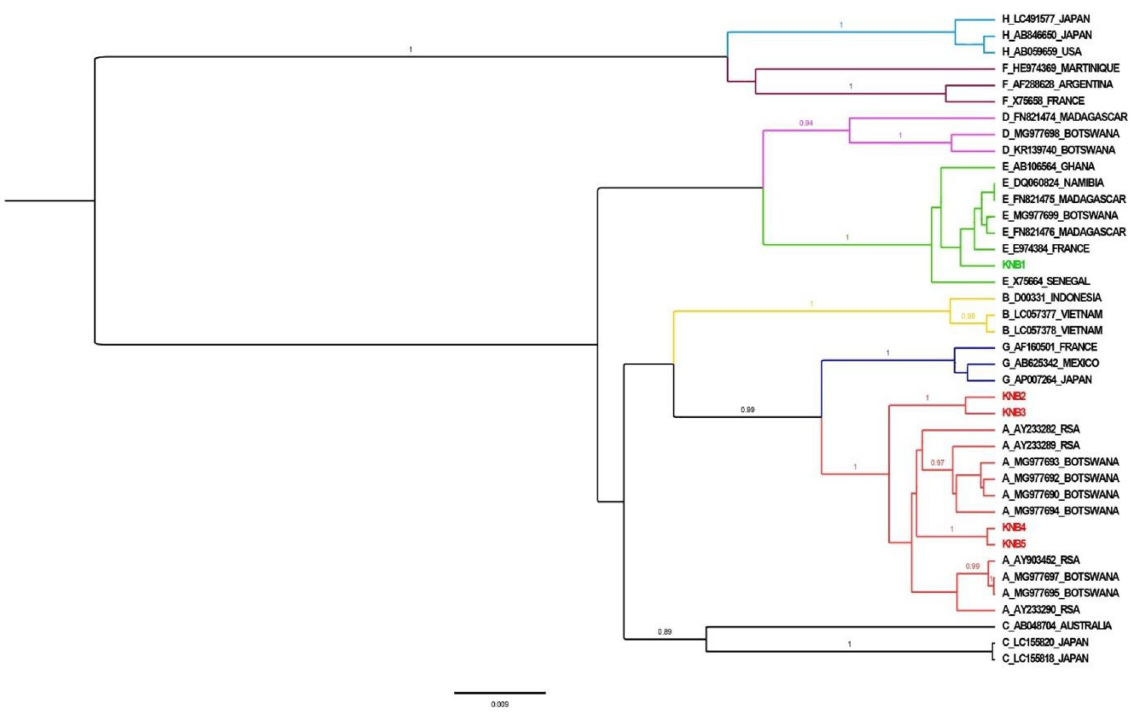
Fig 2. Phylogenetic tree for HBsAg positive mothers sequences (highlighted in red and green) compared to reference sequences (in black).